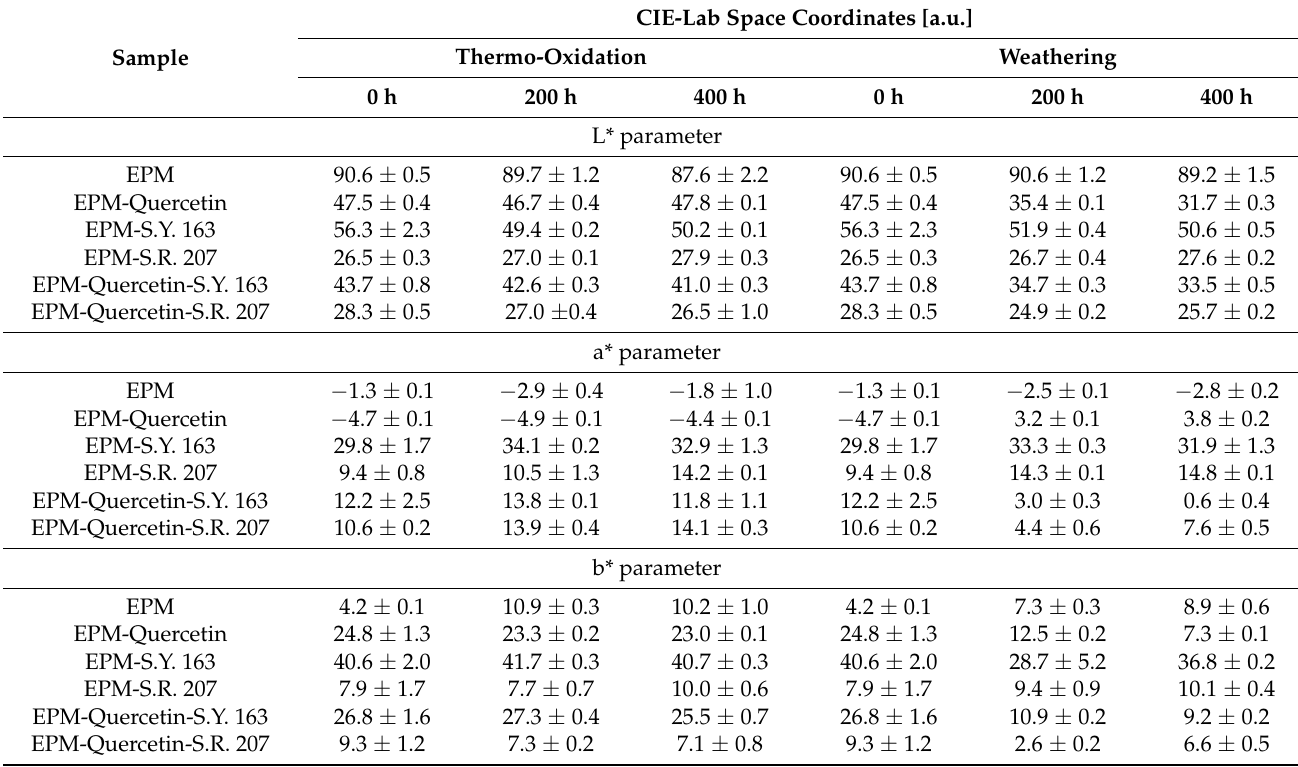
Table 1. L*, a*, and b* coordinates determined in the CIE-Lab space for all tested samples before and after thermo-oxidation and climatic aging.